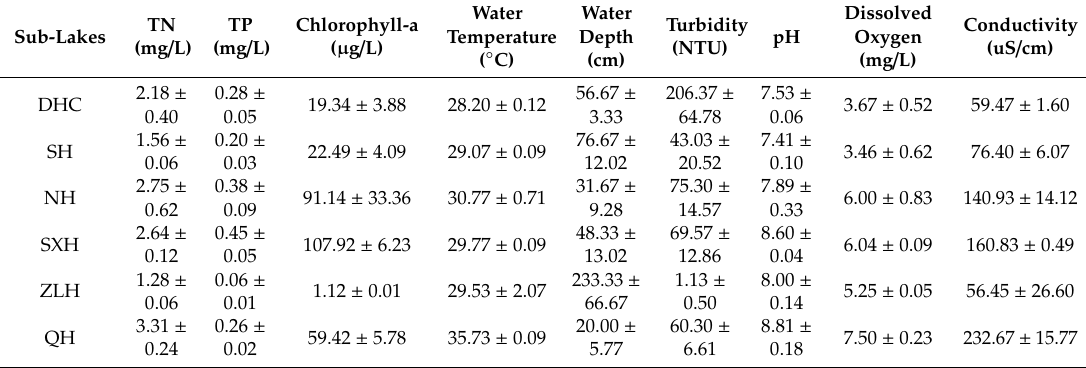
Table 4. Physicochemical parameters in the six studied sub-lakes. Total nitrogen (TN), total phosphorus (TP), chlorophyll a (Chl-a), water temperature (WT), water depth (WD), turbidity (Turb), pH, dissolved oxygen (DO), conductivity (Cond) of six sub-lakes were detected and calculated. Mean ± SE.